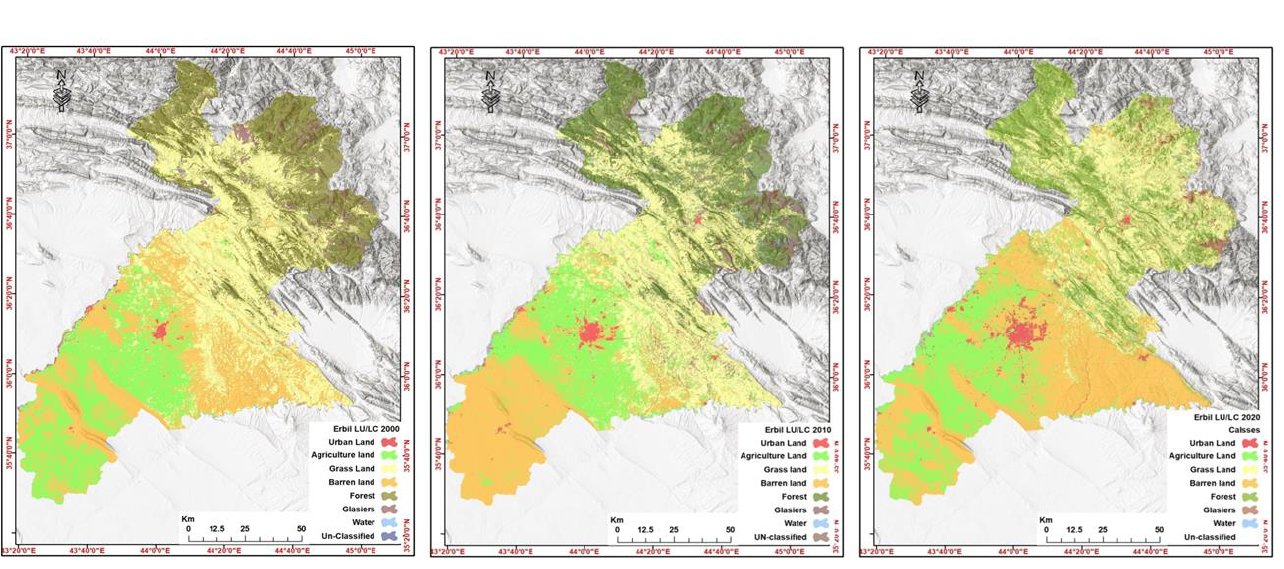
Figure 3. The LULC of the Erbil in 2000, 2010, and